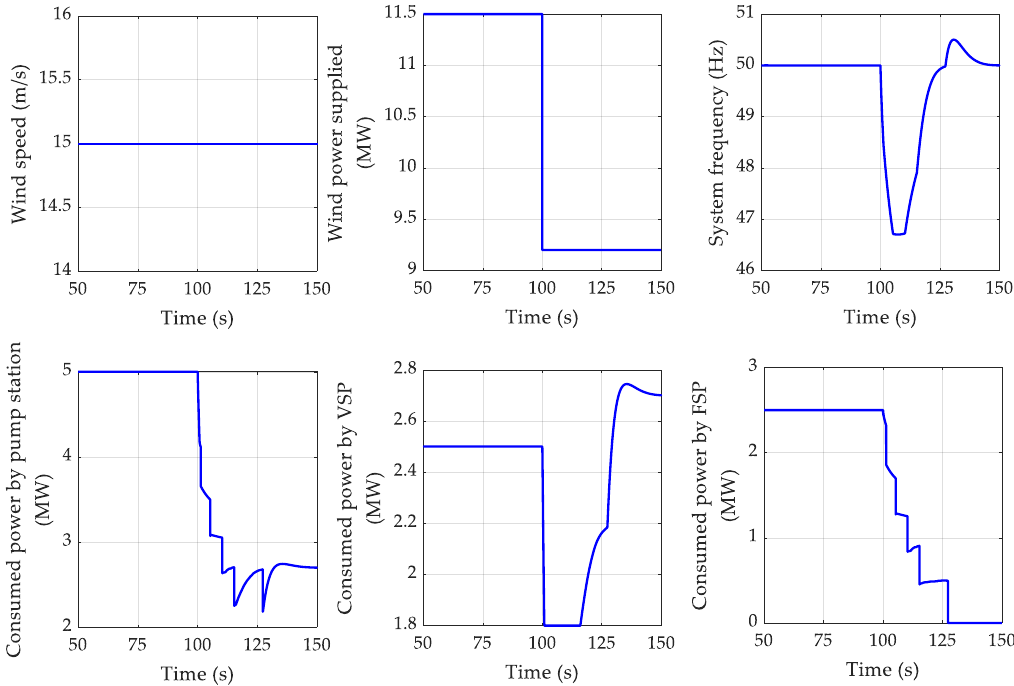
Figure 11. System frequency, power supplied and demanded when a variable-speed wind turbine (VSWT) disconnection takes place.